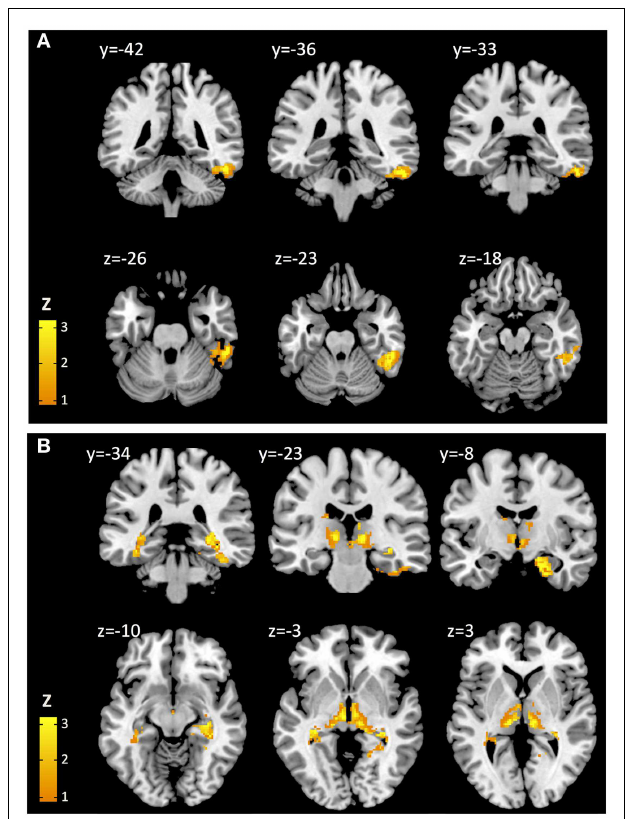
FIGURE 3 | Cerebral voxels (MNI) with significant positive effects of corticalA β on cerebro-cerebellar coupling for seeds representing cerebellar lobeVI (A) and lobe X (B), respectively